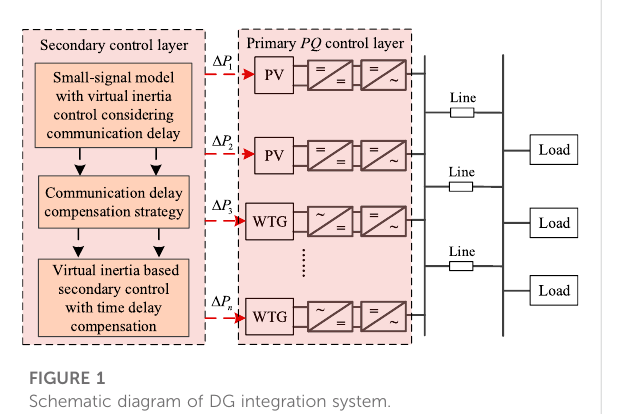
FIGURE 1 Schematic diagram of DG integration system.